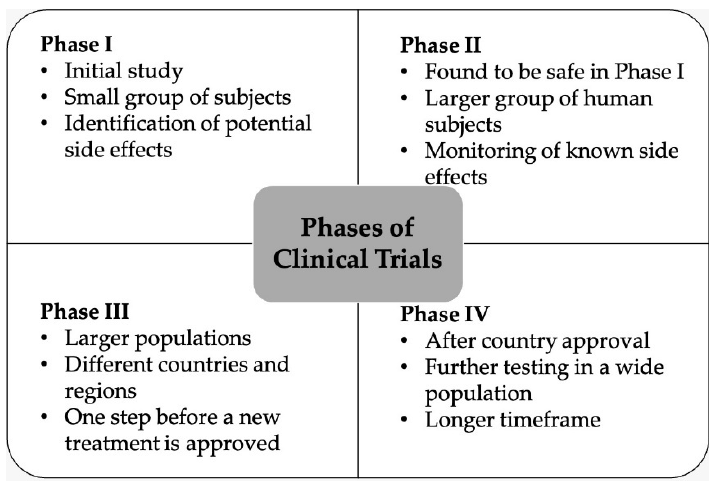
Figure 2. A summary of the phases of clinical trial according to the WHO.